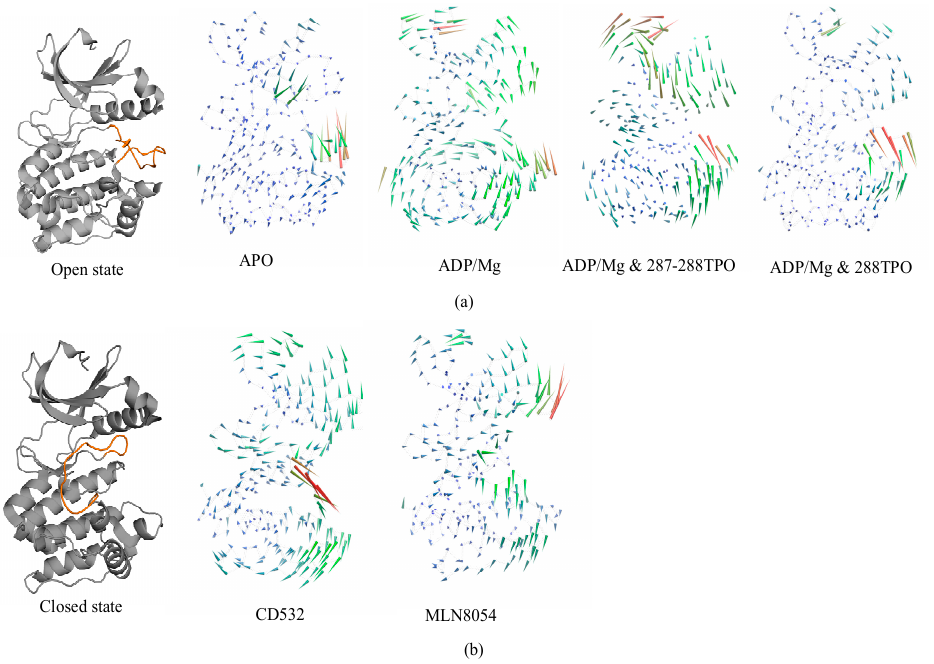
Figure 6. Porcupine plot showing the significant motions across the first PC. ( a ) the open/active states: apo (4J8N), ADP/Mg (1MQ4), ADP/Mg with two TPO (1OL7), ADP/Mg with single TPO (1OL7). ( b ) the inactive states: CD532 (4J8M) and MLN8054 (2WTV). The color of the protein strands is related to the extent of motion, and arrows show the direction of the correlated motion. Red reflects the highest movement followed by green, whereas blue depicts the least moving parts of the protein.